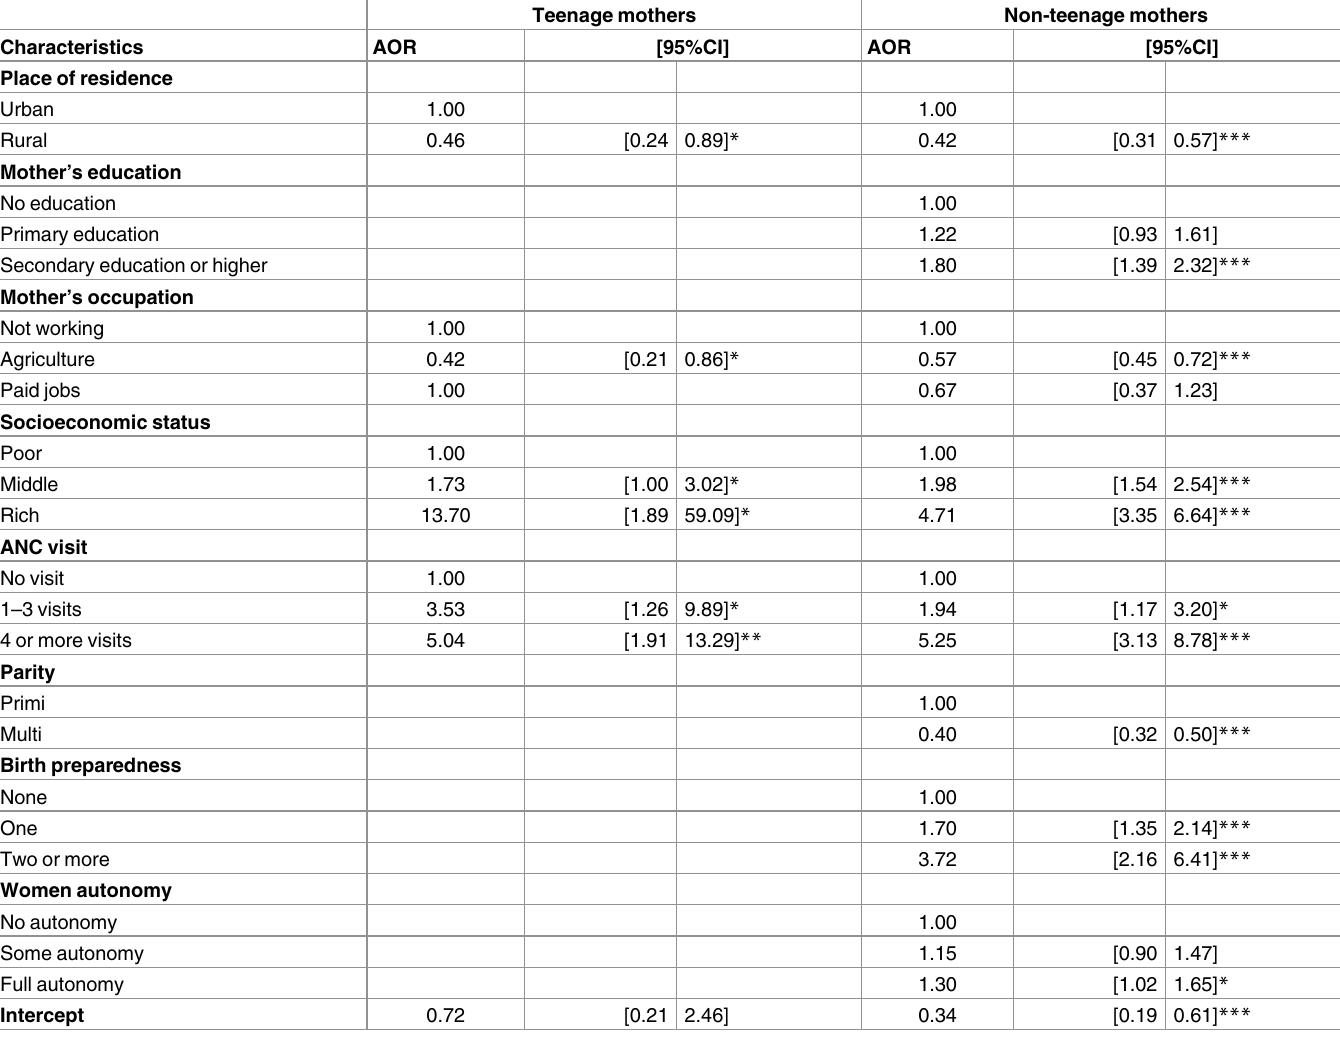
Table 3. Factors associated with the institutional delivery among teenage and non-teenage mothers in Nepal- NDHS 2011 (N = 5391).